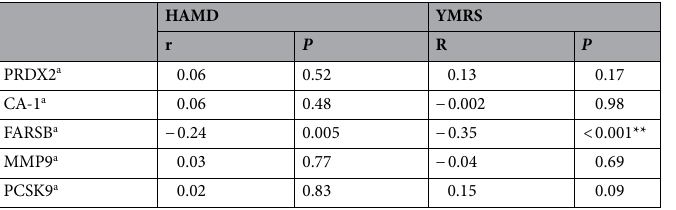
Table 2. Correlation between level of protein levels and mood severity in BD-II (training group). HAMD Hamilton depression rating scale, YMRS Young manic rating scale. r: Pearson’s correlation coefficient. * P < 0.05;